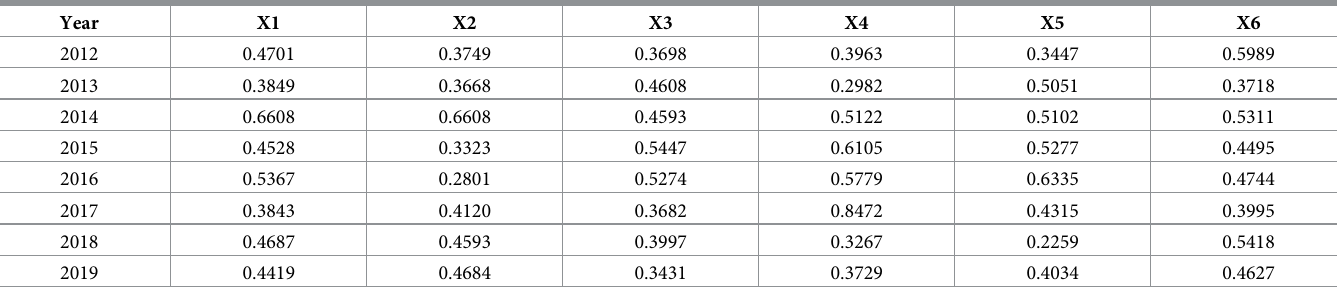
Table 5. Results of coupling coordination influence factor